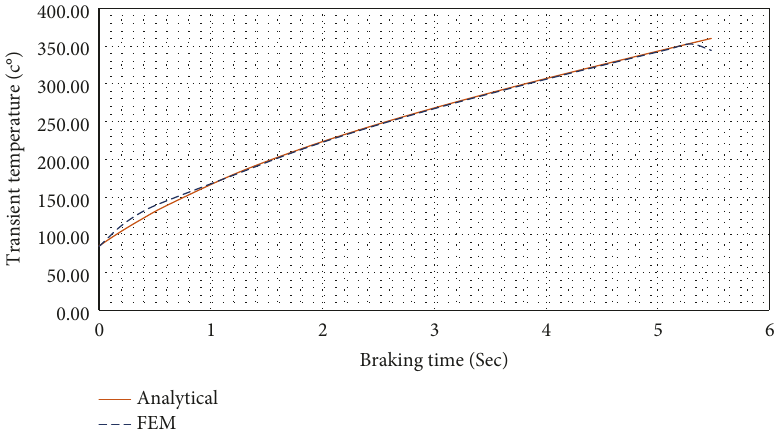
Figure 10: Transient temperature distribution at different braking times.